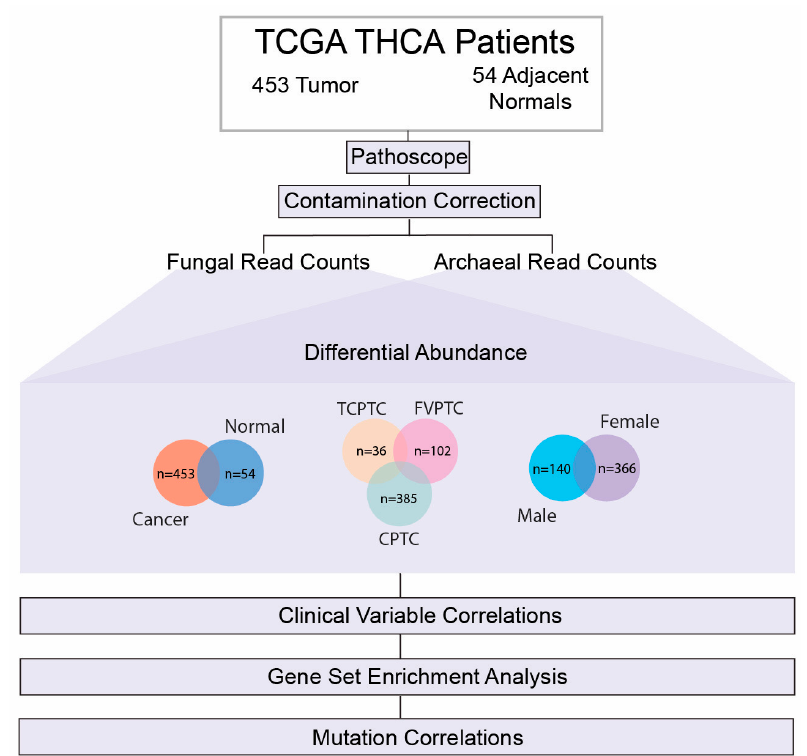
Figure 1. Schematic of analysis pipeline used for this study. Raw RNA-sequencing data were downloaded from The Cancer Genome Atlas (TCGA) for 453 PTC patients and 54 adjacent normal samples. The PathoScope 2.0 software was used to align RNA-sequencing files to NCBI nucleotide database’s reference genomes and extract fungal and archaeal read counts. Following sequencing alignment, multiple contamination correction methods were used to identify and remove potential contaminants from downstream analyses. In order to characterize the fungal and archaeal microbes pertinent to PTC, we first compared differentially abundant species in following cohorts: (1) 453 PTC samples and 54 adjacent normal samples; (2) 385 CPTC, 102 FVPTC, and 36 TCPTC samples; (4) 140 male cancer samples and 366 female cancer samples, utilizing Kruskal–Wallis testing ( p -value < 0.05). Following differential abundance analysis, significantly dysregulated microbes were correlated to clinical variables pertinent to PTC prognosis and outcomes. Dysregulated microbes were also correlated to known signature pathways specific to PTC oncogenesis through Gene Set Enrichment Analysis (GSEA). Finally, we correlated abundance of these microbes according to status of the BRAF V600E mutation in our patient cohort.